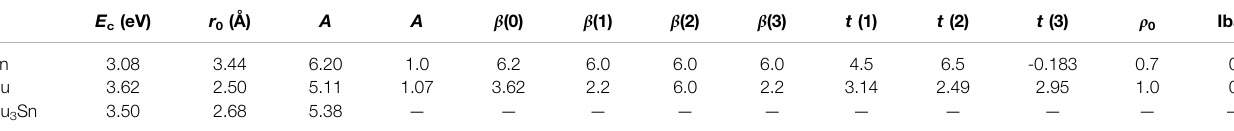
TABLE 1 | Parameters of the MEAM potential used in the